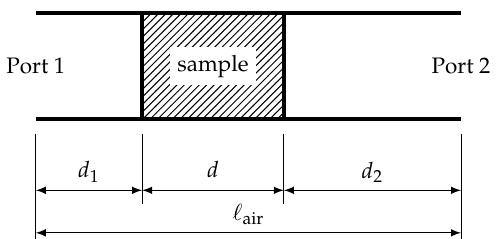
Figure 7. Schematic representation of the measurement setup in a